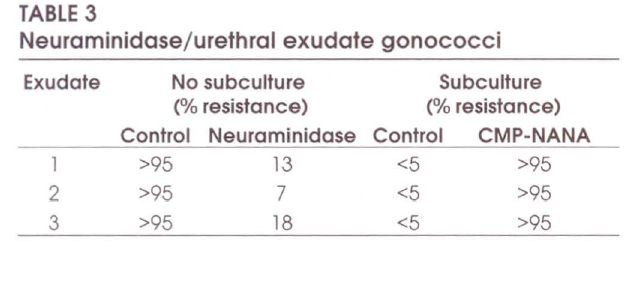
Neuraminidase/ urethral exudate